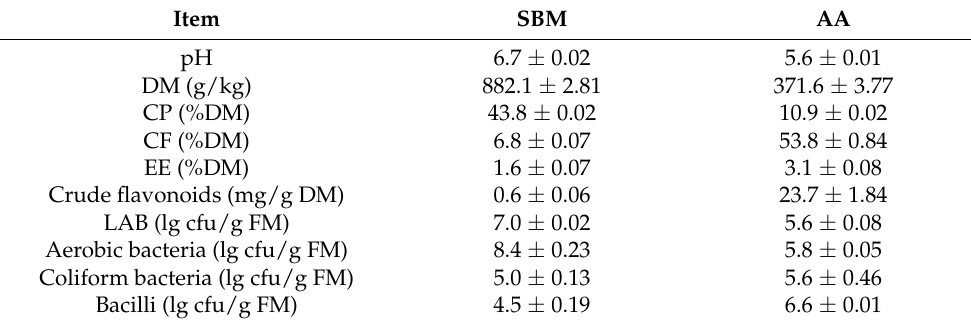
Table 1. Chemical composition and microbial population of SBM and AA (Mean ± SD, n = 3). Item SBM AA pH 6.7 ± 0.02 5.6 ± 0.01 DM